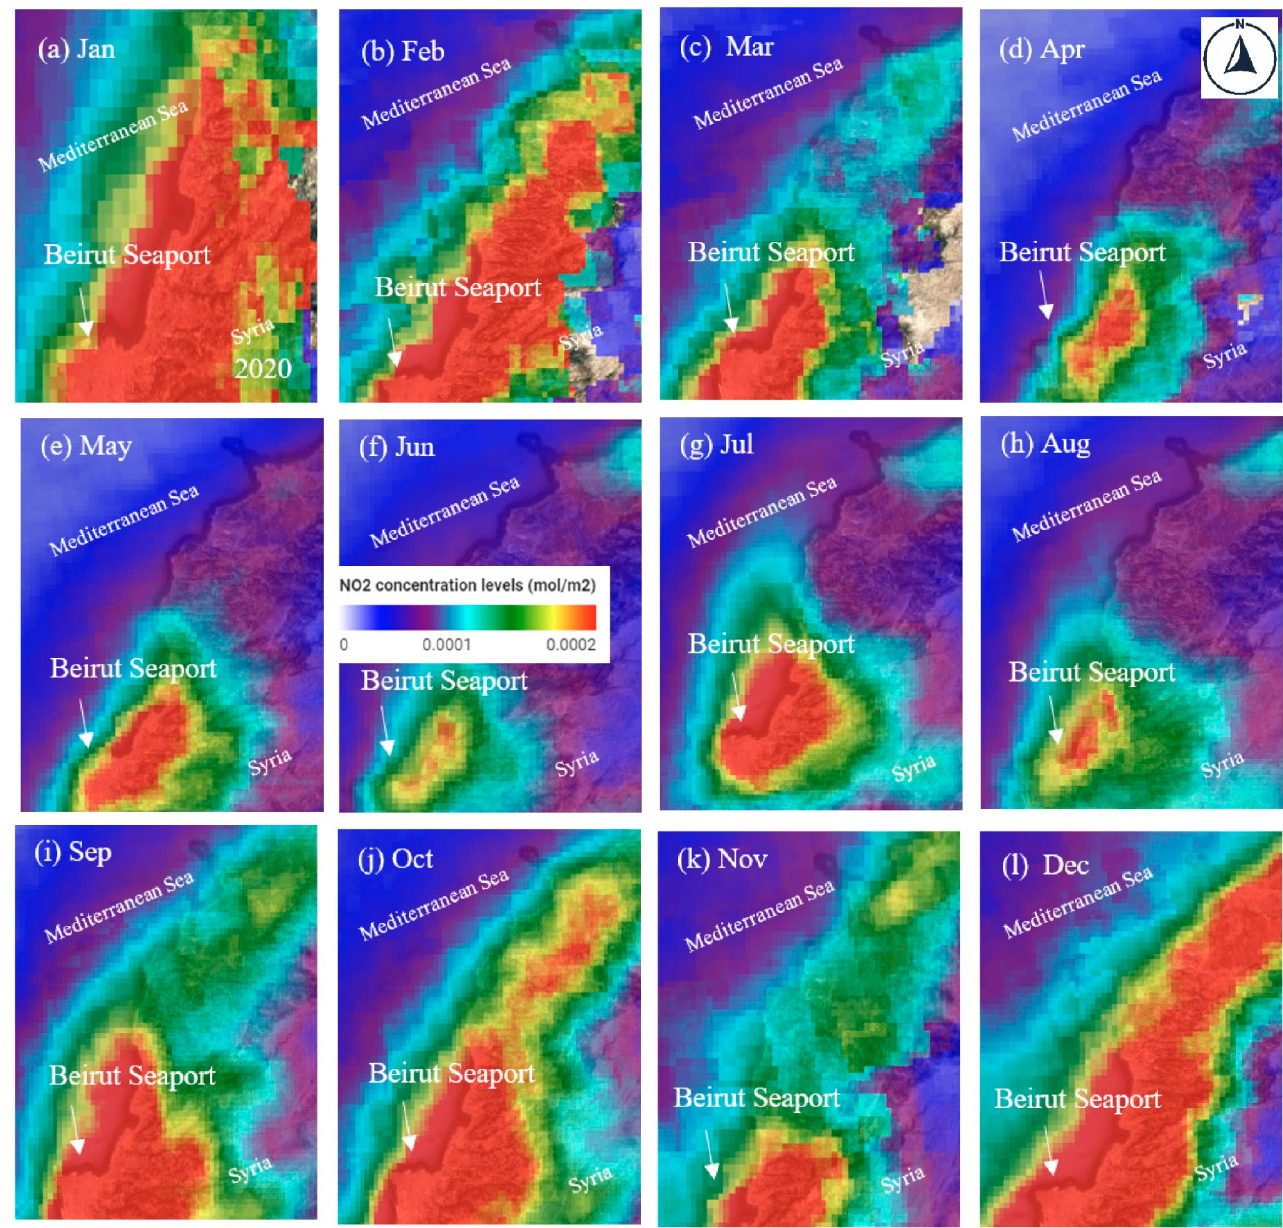
Figure 4. NO 2 concentrations over Beirut, Lebanon from January to December 2020. The Beirut blast occurred on 4 August 2020.